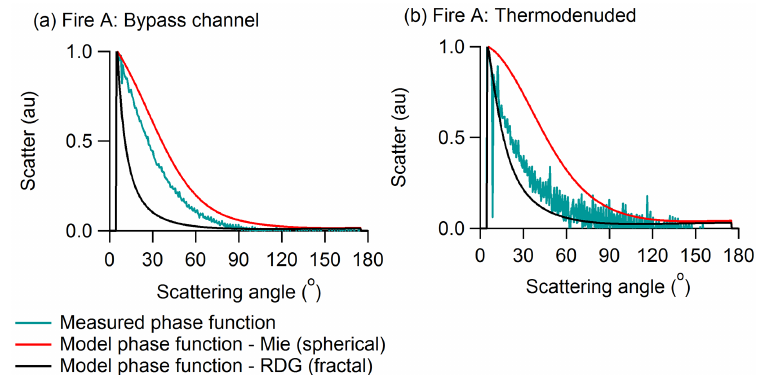
Figure 6. Comparison of measured (blue) phase function at 405nm to Mie theory model (red) and RDG model (black) for one cycle of sampling through bypass channel (a) and after the thermodenuder (b) for Fire A. Phase functions are normalized to unity at 5 ◦ scattering angle. Mie theory calculations are based on HULIS refractive index (Dinar et al., 2008) and RDG calculations are based on the ponderosa pine parameterization (Chakrabarty et al., 2006).